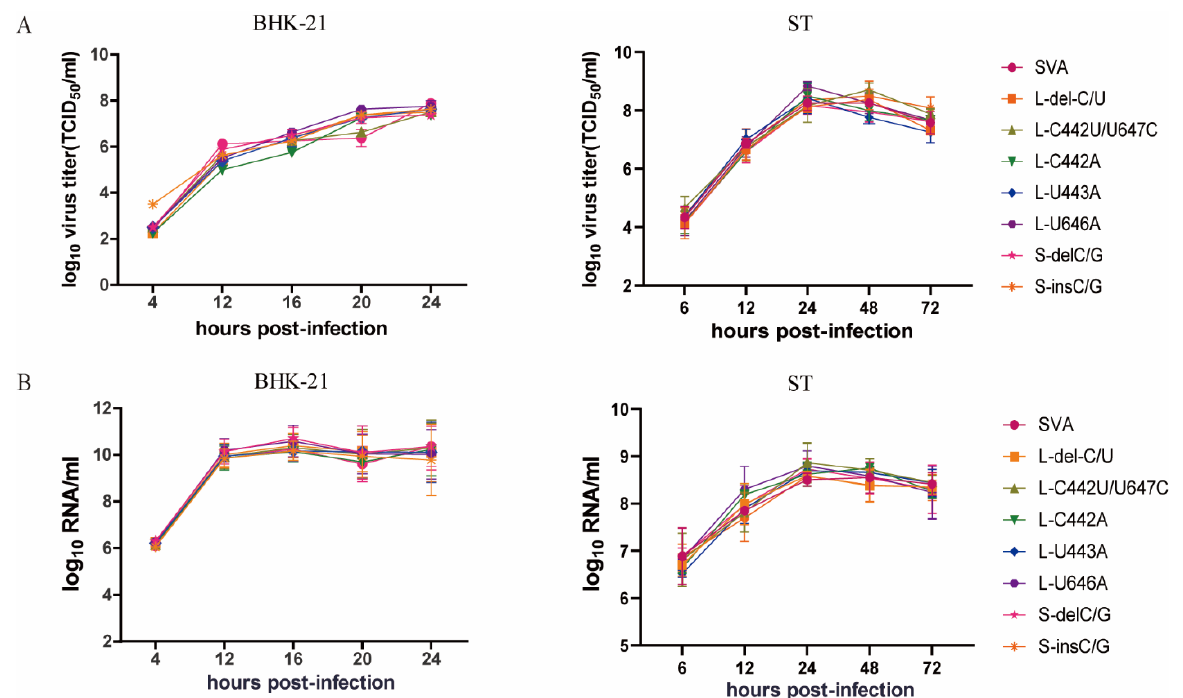
Figure 5. Replicating ability of SVA stem-loop I mutants. BHK-21 and ST cells were infected with mutants at an MOI of 0.01. The viruses produced were harvested at different times, and virus titers were determined as TCID 50 /mL in BHK-21 cells and ST cells. Growth curves ( A ) and viral RNA loading ( B ) of mutants or SVA are shown. Error bars represent +SD (n = 3).